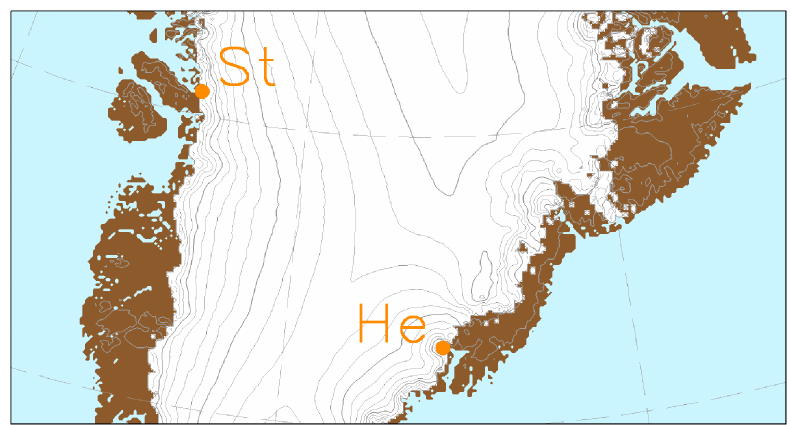
Figure 2. Geographical position of the outlet glaciers mentioned in the main text. “St” indicates the location of Store Glacier, while “He” marks the position of Helheim